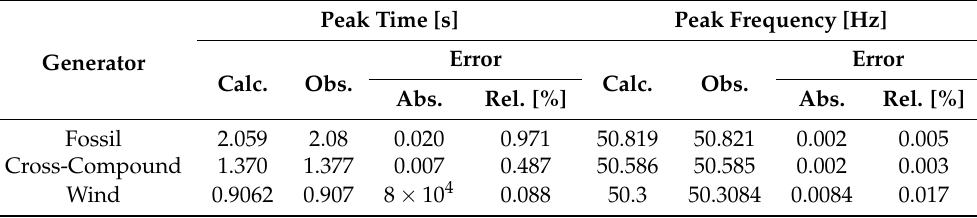
Table 2. Comparison for analytical and generic